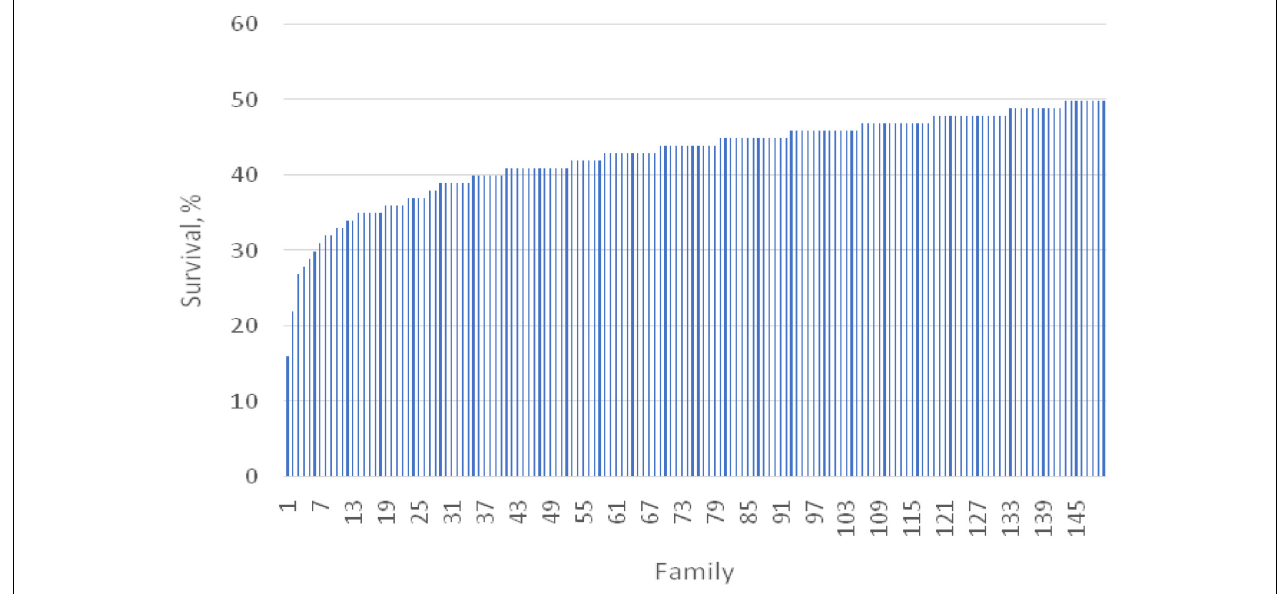
FIGURE 2 | Variation in survival rate among 150 families involved in the challenge test in 15